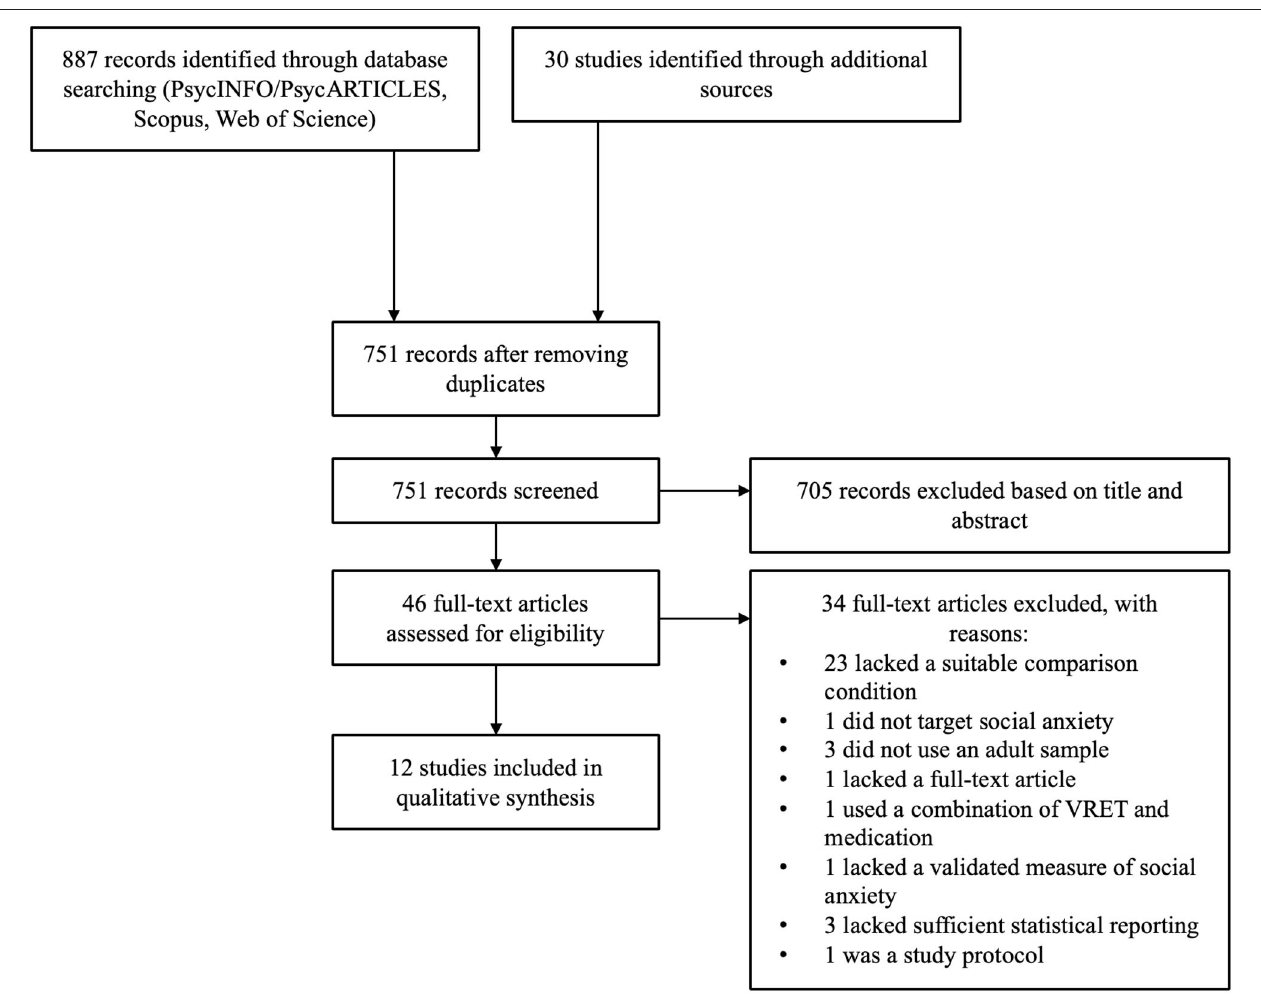
FIGURE 1 | PRISMA-ScR